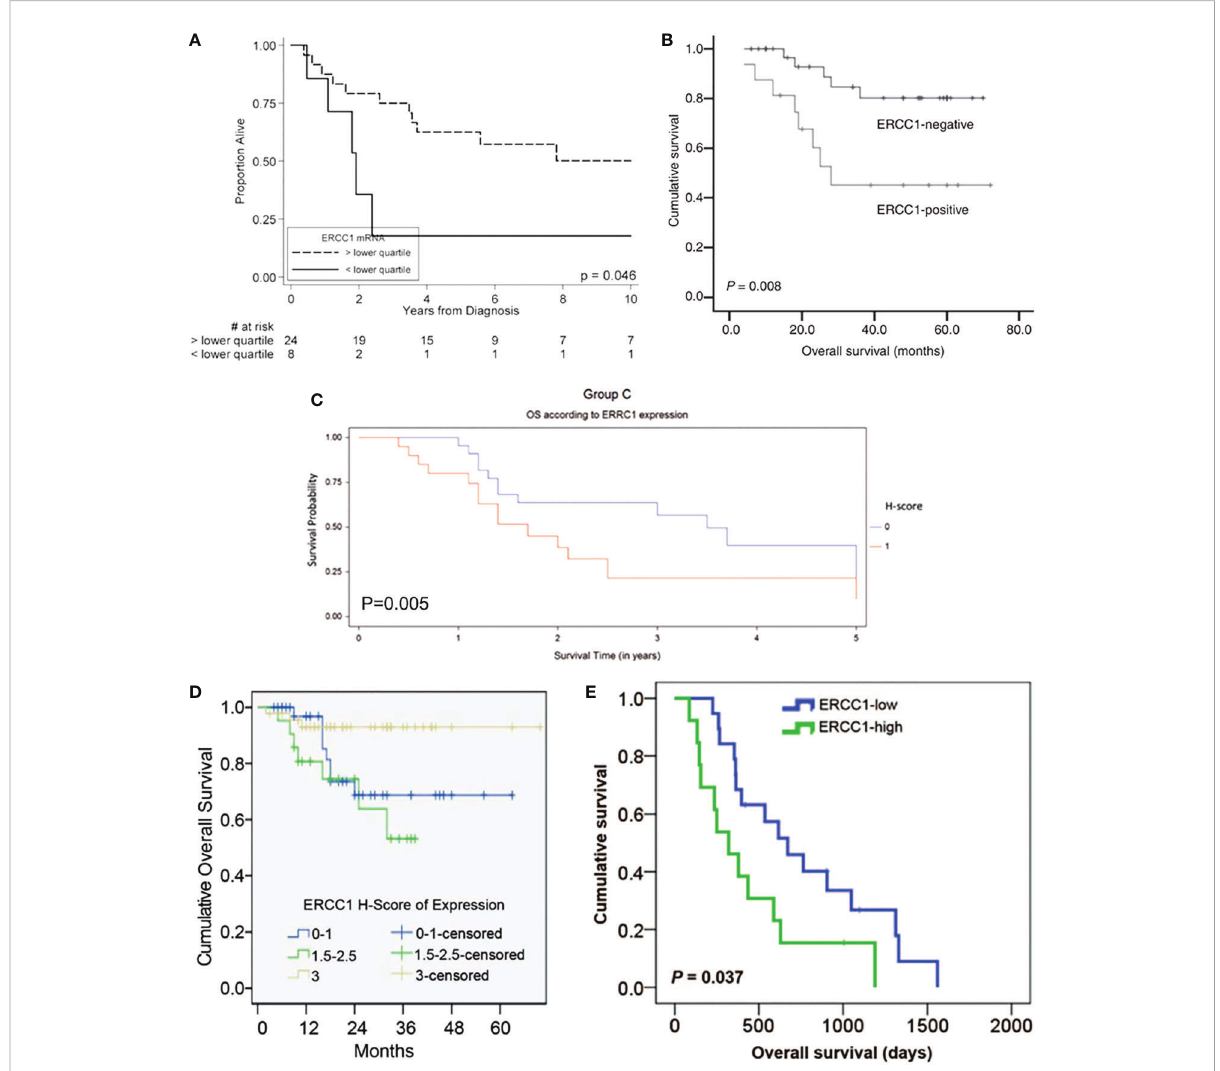
FIGURE 1 Kaplan-Meier overall survival curve strati fi ed by ERCC1 status that reported in fi ve included studies with the corresponding citation. (A) derived from the study of (24), namely A = (24); B = (29); C = (30); D = (23); E =